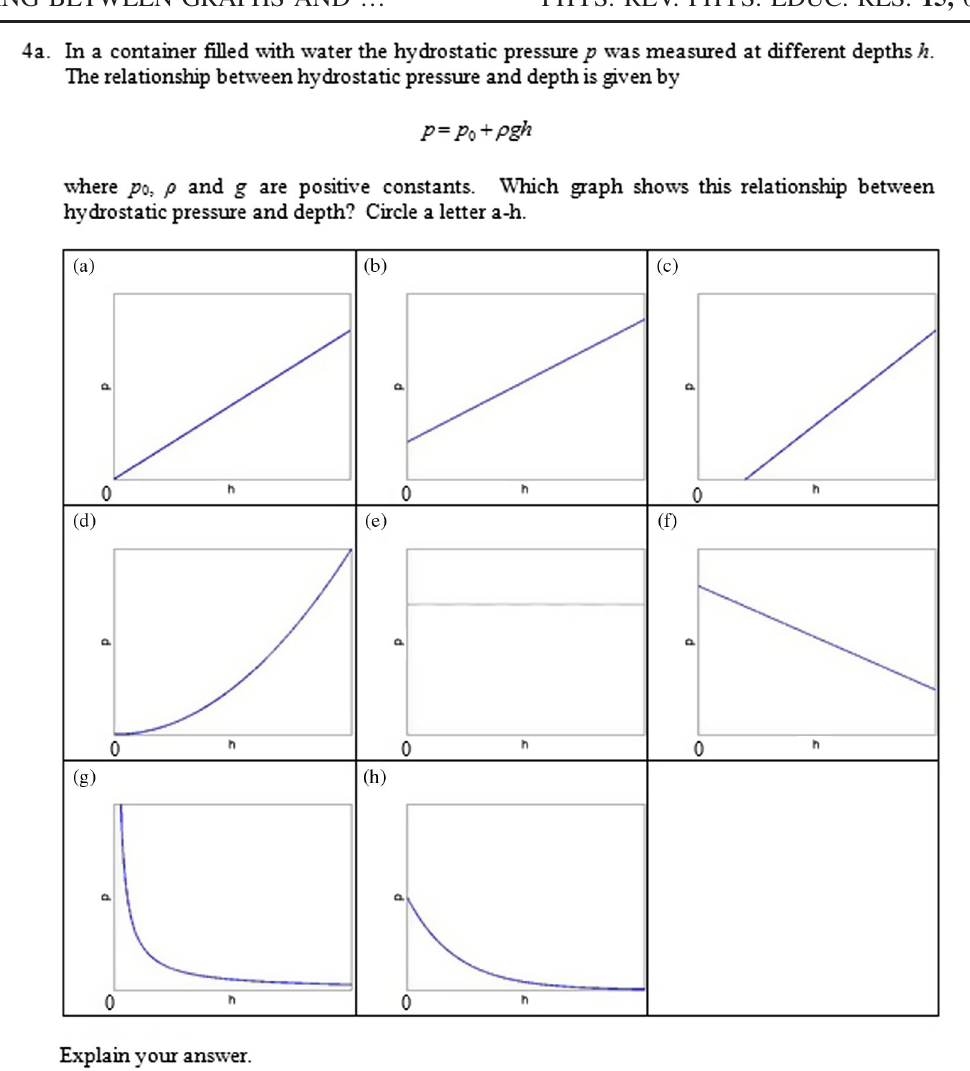
FIG. 3. Example of a test item about an increasing affine function in a physics context, translating from a symbolic to a graphical